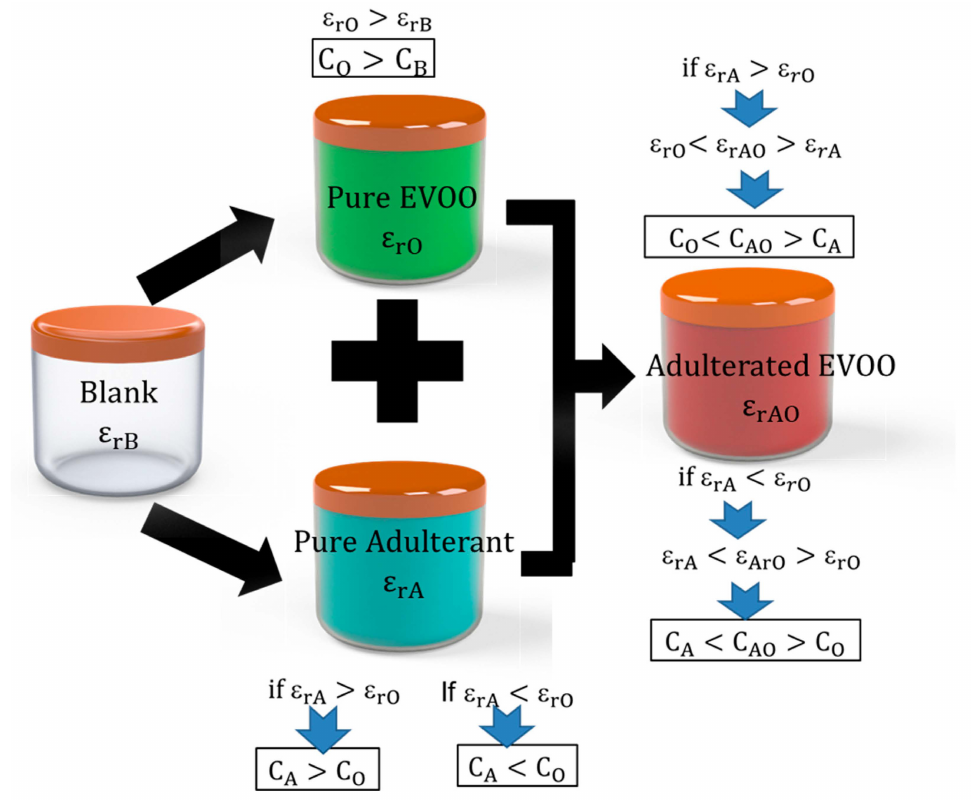
Figure 5. Schematic showing the working principle of capacitive detection of oil